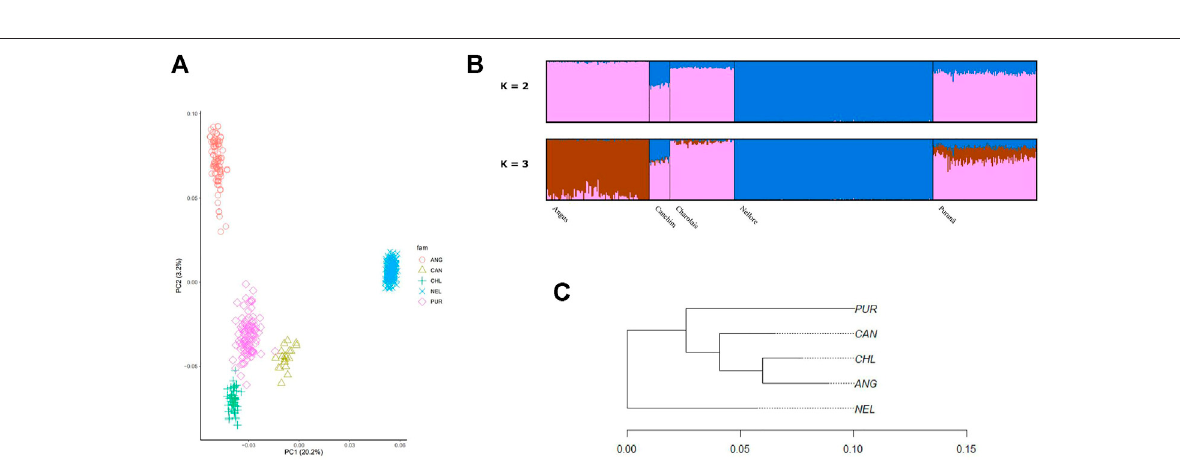
Frontiers in Genetics |